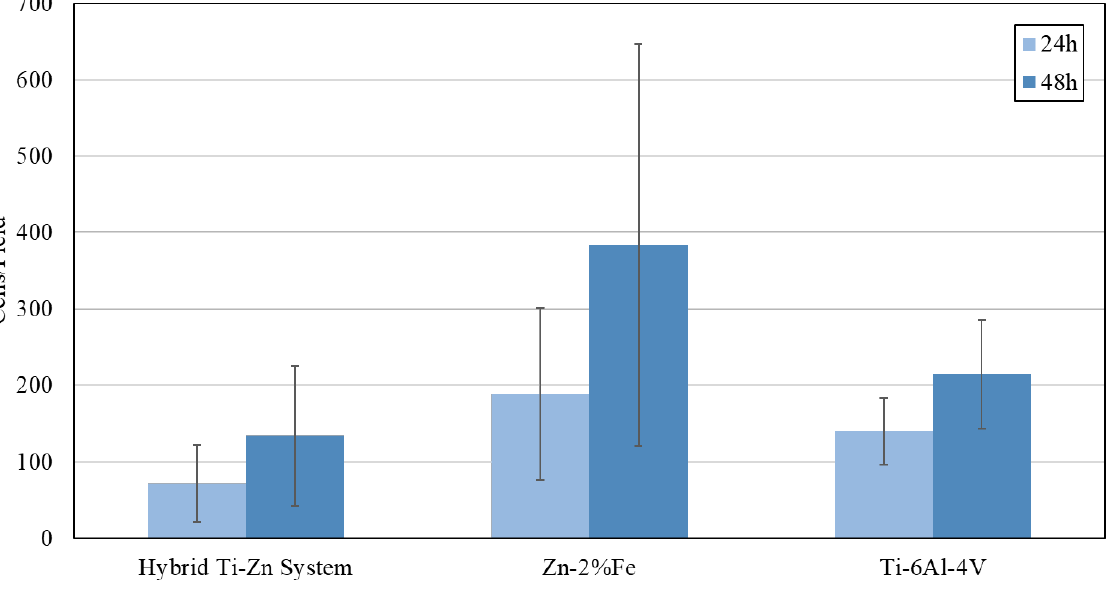
Figure 9. Fluorescence images of live (green) and dead (red) 4T1 cells attached to the corresponding alloys after 24 and 48 h of incubation. Scalebar = 100 μm . 4. Discussion Zn-based bioabsorbable implants are gaining popularity due to z inc’s biocompatibil- ity, potential bone growth stimulation and anti-inflammatory properties, in addition to dissolvability in a biological environment. The main corrosion products of Zn are Zn(OH) 2 and ZnO that are converted in the physiological environment to soluble chlo- ride salts that can be efficiently exerted from the body through the kidneys, preventing cytotoxicity. Furthermore, Ti-based alloys, particularly Ti-6Al-4V, are commonly used as